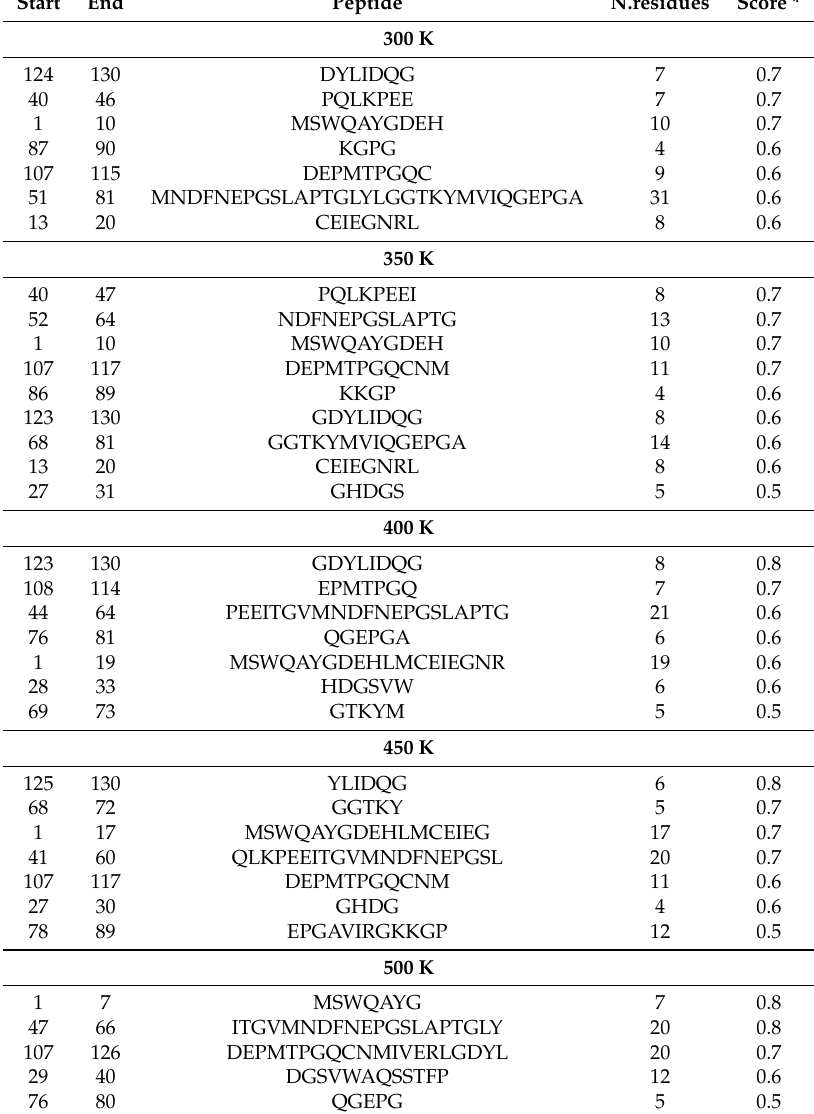
Table 3. Epitope prediction of the last frame of MD simulation at different